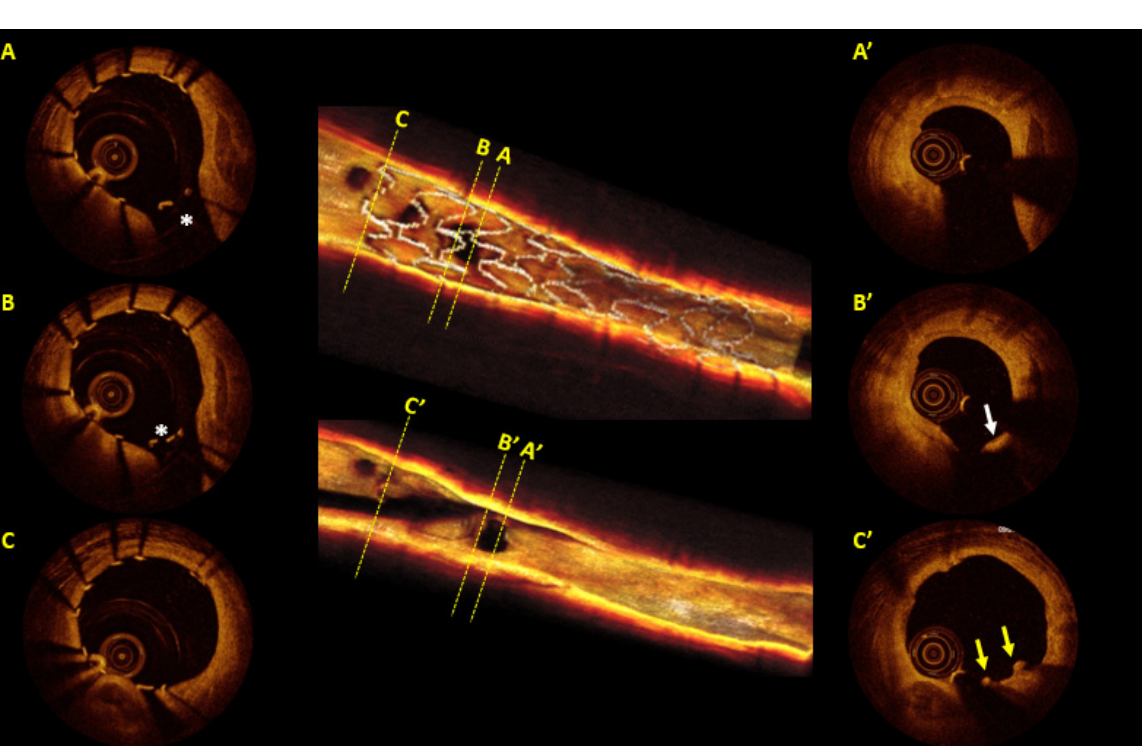
Figure 2. Post-implantation and 12-month follow-up optical coherence tomography (OCT; LightLab Imaging, Westford, MA, USA) of a percutaneous coronary intervention of the left anterior descending coronary artery, whereby a 3.25 × 16 mm paclitaxel-eluting absorbable metal scaffold (DREAMS 1G; Biotronik, Bülach, Switzerland) was implanted. Post-procedurally a side branch was jailed by the struts of DREAMS 1G (Panels A and B ). At 12 months follow-up, OCT showed a smooth luminal surface with moderate neointimal hyperplasia in the scaffolded segment. Just few remnants of struts were still visible with shadows (panel C’ , yellow arrows). The struts overhanging a side branch ostium were partially replaced by a neointimal membranous bridge (panel B’ , white arrow), while three-dimensional OCT revealed unobstructed and widely opened ostium of side